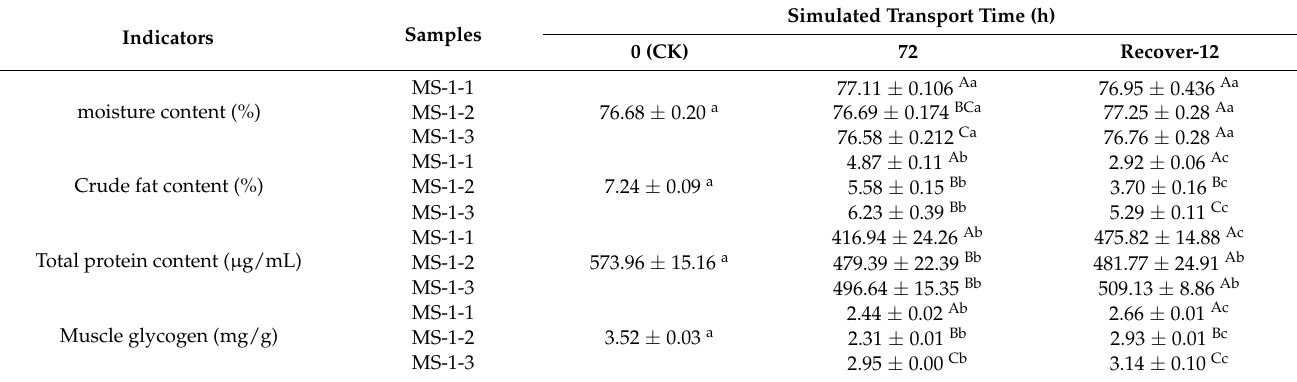
Table 3. The changes in basic nutrients of the sea bass before and after simulated live